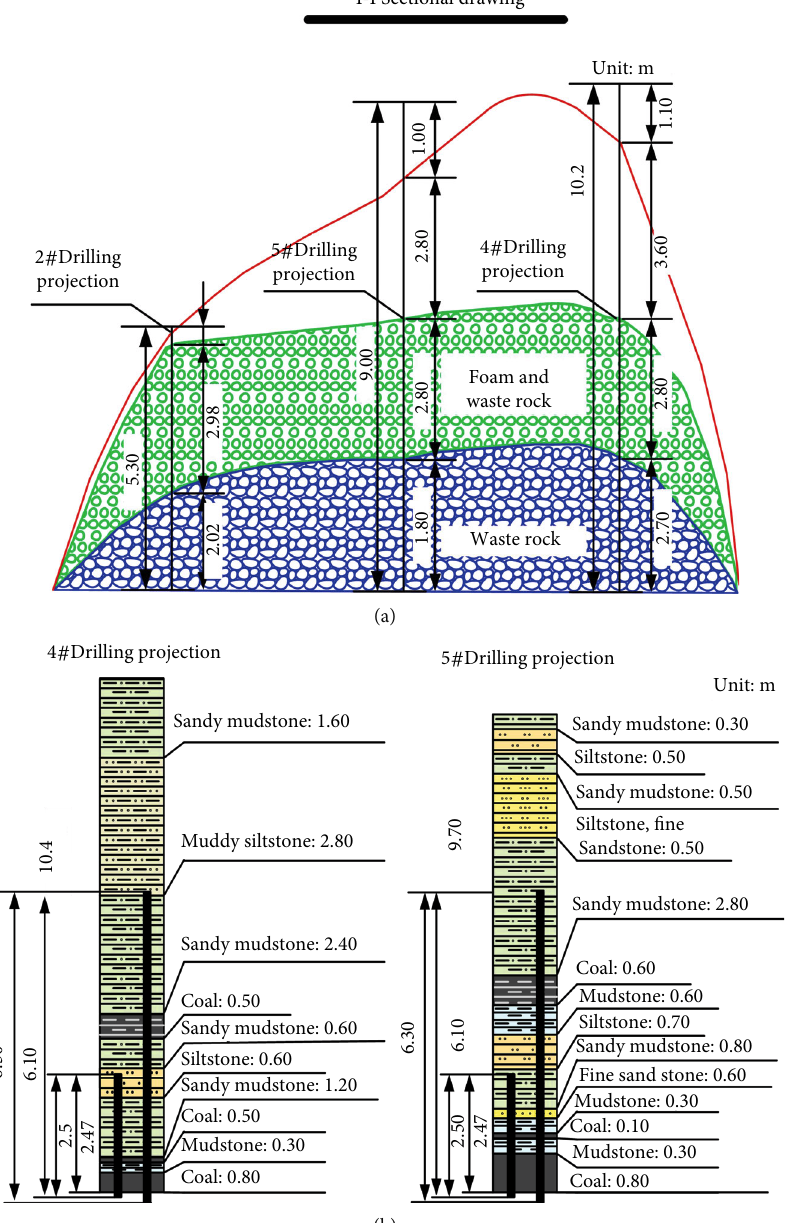
Figure 2: The diagrammatic cross-section of caving zone: (a) the schematic diagram of drilling section; (b) the columnar section of